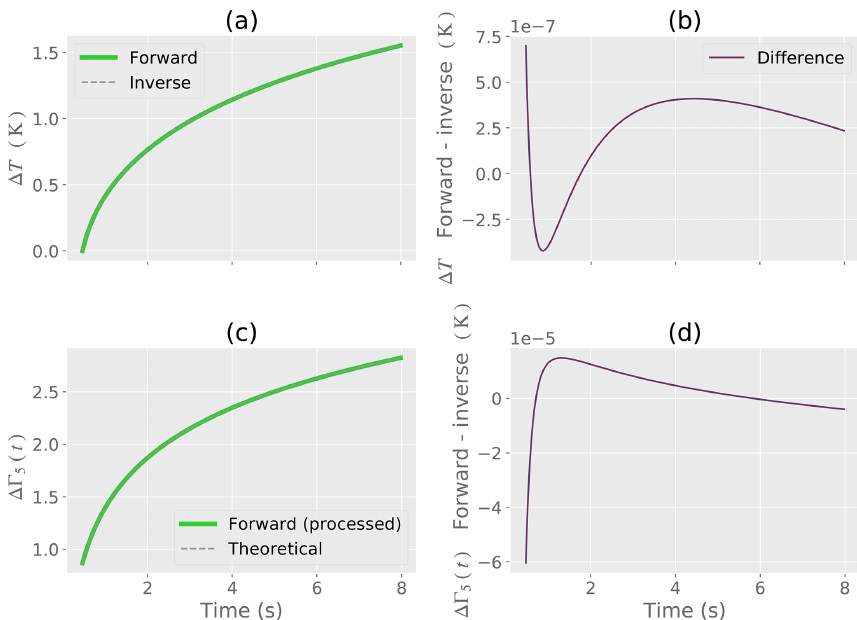
Figure 3. Synthetic example of SP signal processing. (a) Forward model and reconstruction of the forward model by the inverse model. (b) Numerical difference between the forward and inverse models. (c) Forward model (cid:49)(cid:48) 5 (t) from the signal processing compared to the theoretical model of (cid:49)(cid:48) 5 (t) . (d) Numerical difference between the forward model (cid:49)(cid:48) 5 (t) and the theoretical model.